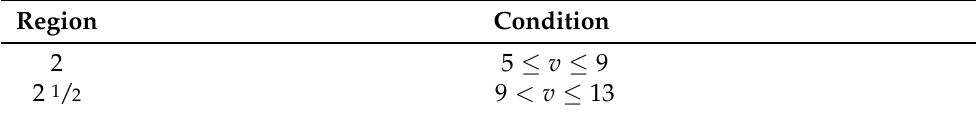
Table 1. Operation regions for the test case wind turbine.